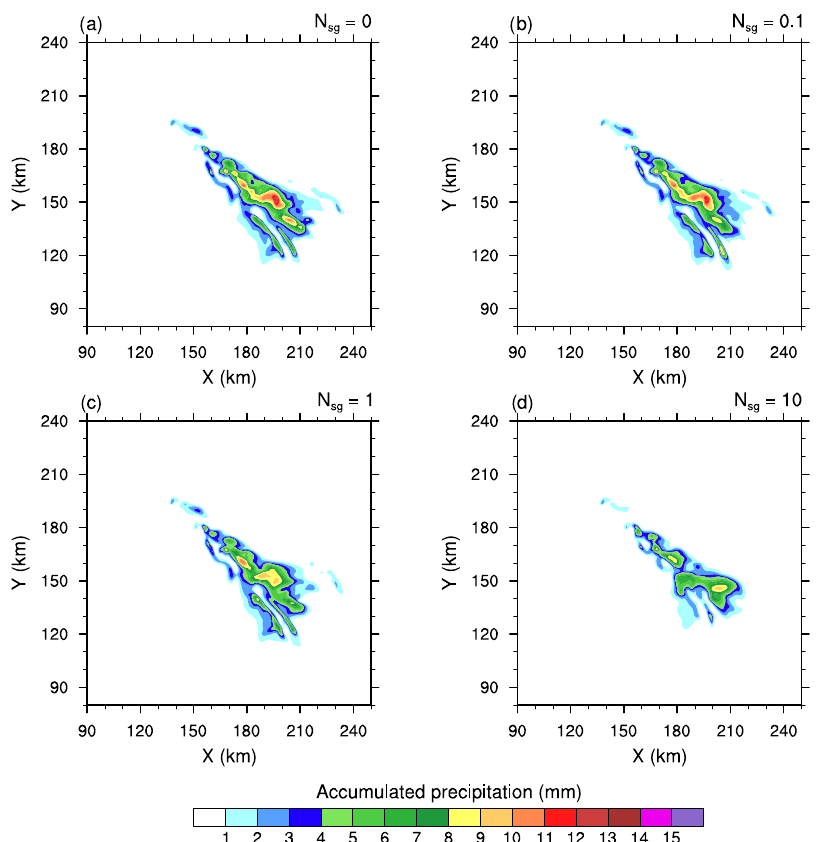
Figure 1. The 4h accumulated precipitation of the STERAO simulations, where panels (a) – (d) refer to cases with N sg = 0 . 0, 0.1, 1.0, and 10.0 ice fragments per collision, respectively. The plots are for a fraction of the computational domain.